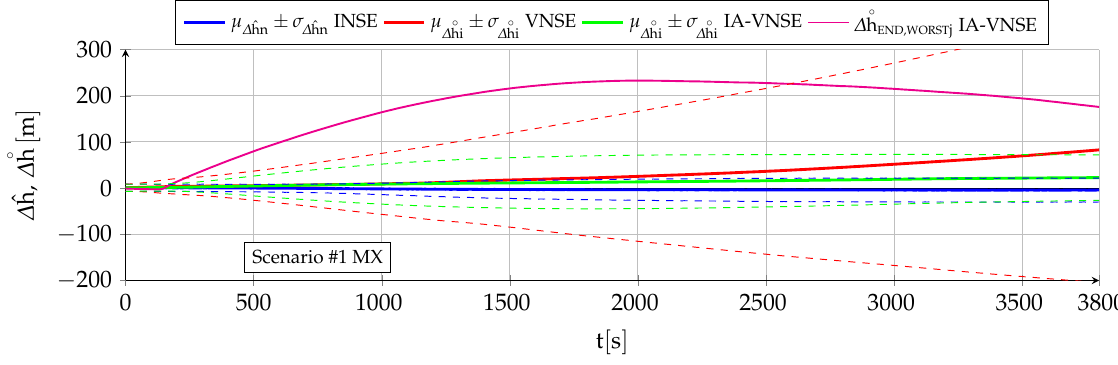
Figure 11. Vertical position INSE, VNSE, and IA-VNSE for scenario #1 MX (100 runs).